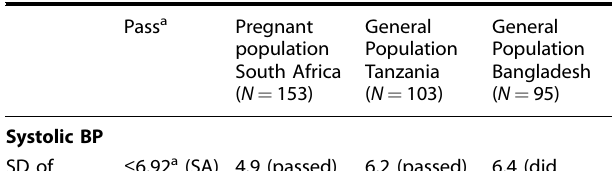
Table 4. Performance CamBP device – ISO Criterion 2.